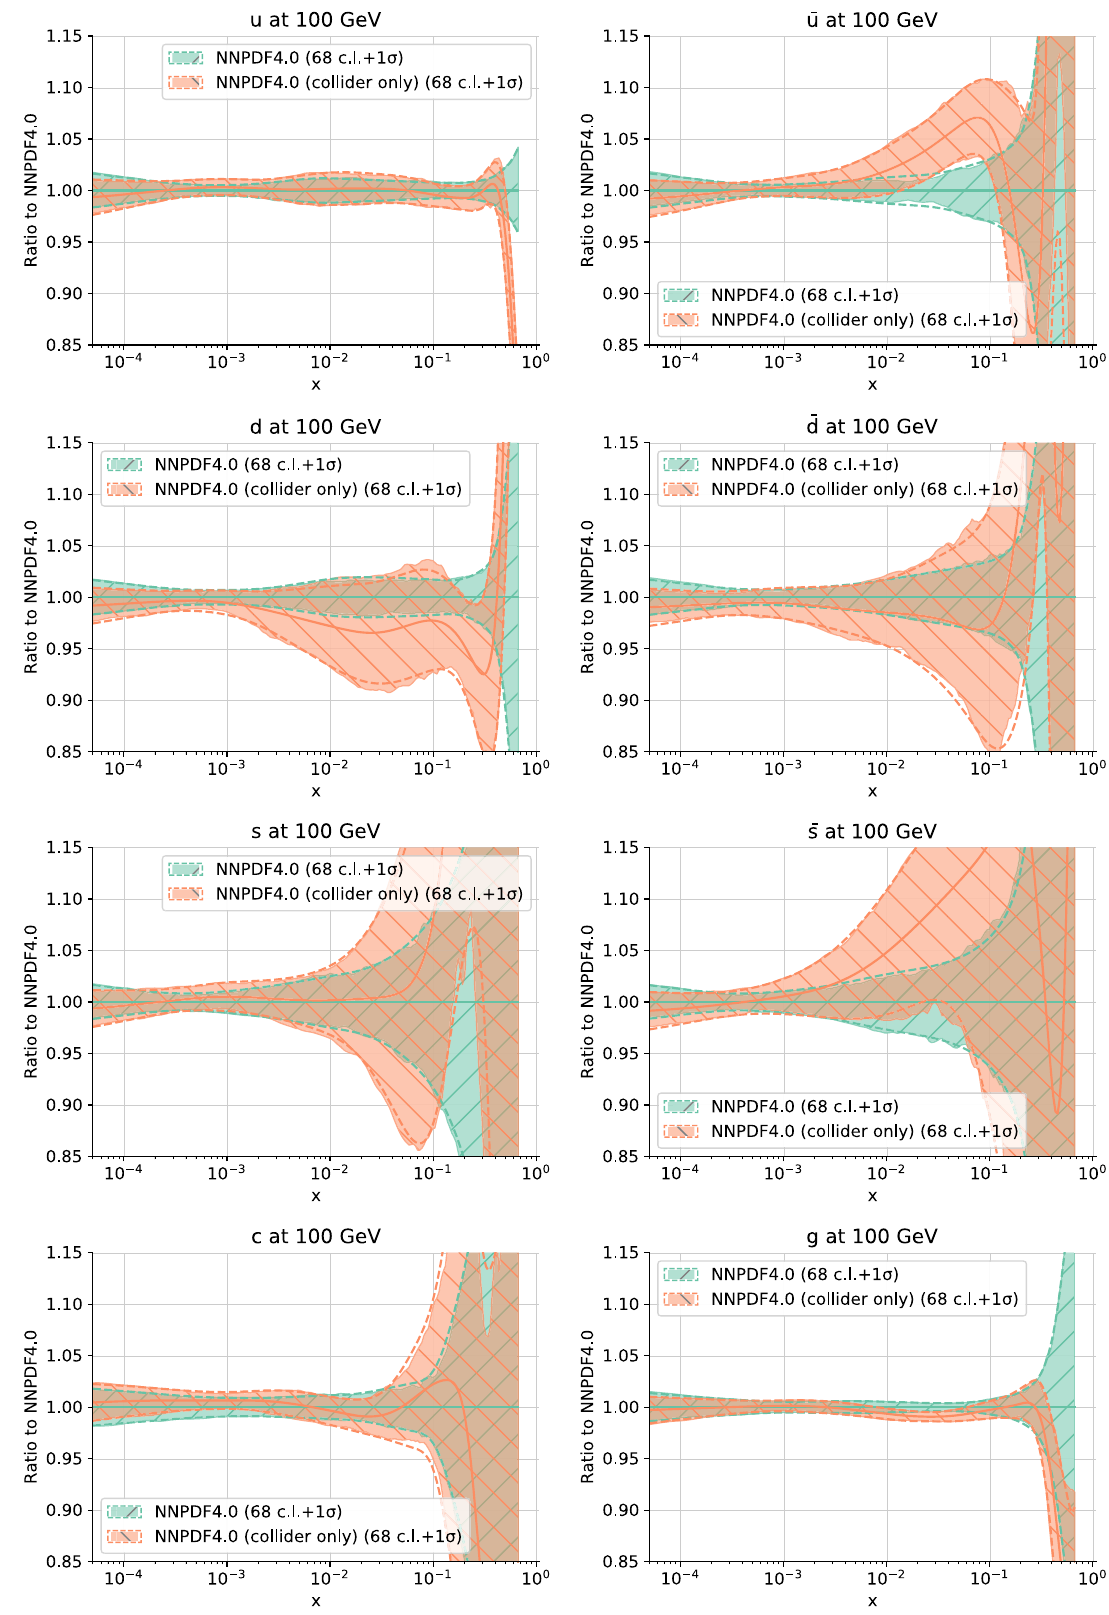
Fig. 39 Same as Fig. 31 now comparing the baseline to PDFs determined excluding all fixed-target data from the dataset (collider-only